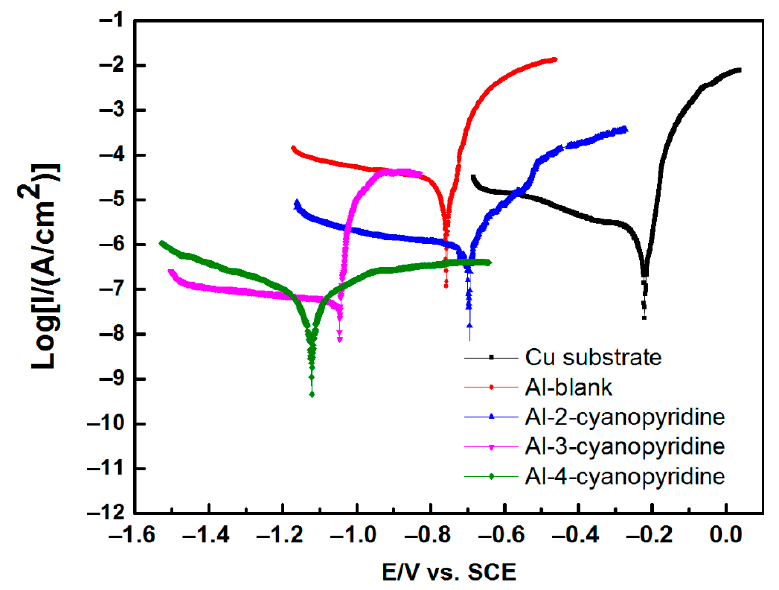
Figure 9. Polarization curves of different Al alloy coatings on Cu substrate in 3.5 wt.% NaCl solution at a scan rate of 1 mV/s. Table 2. Corrosion parameters received from the polarization curves in Figure 9.